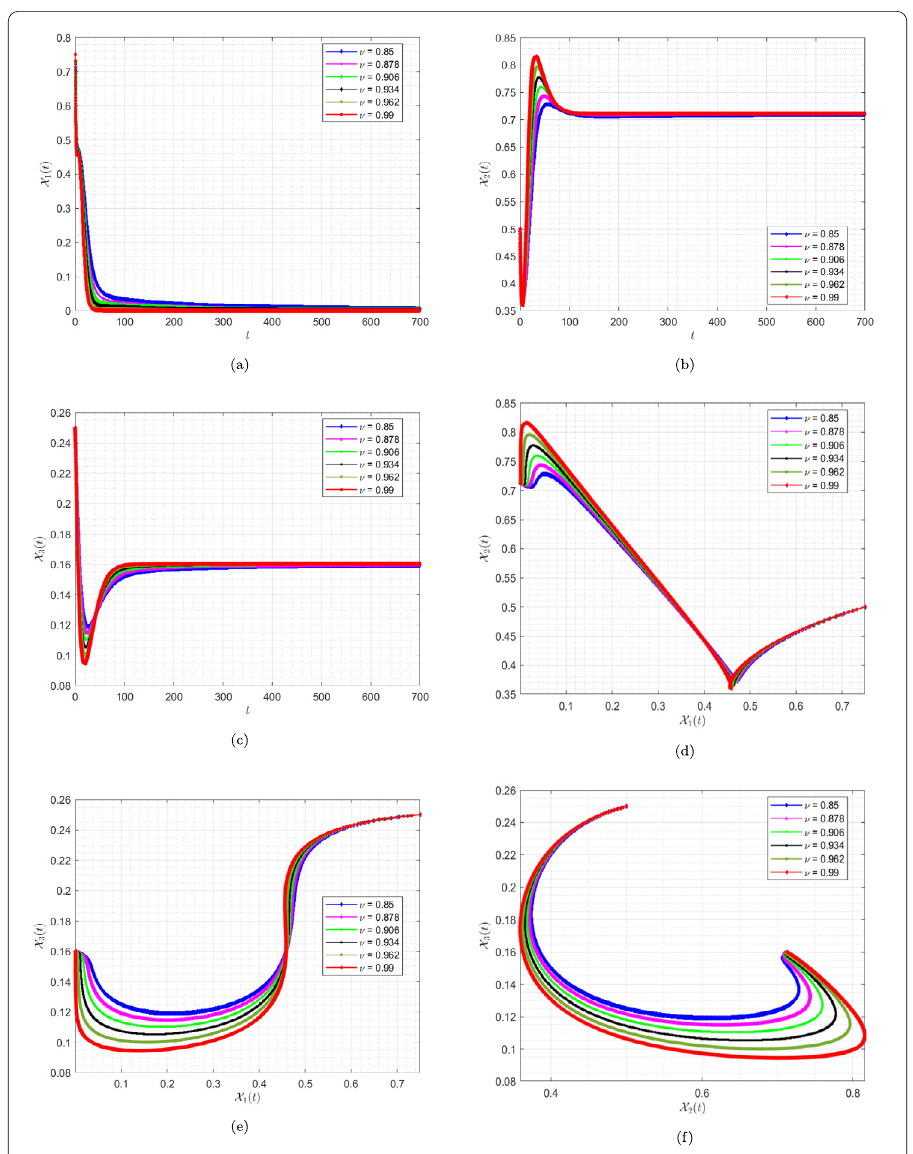
Figure 5 Dynamics for system (19) for different parameters in